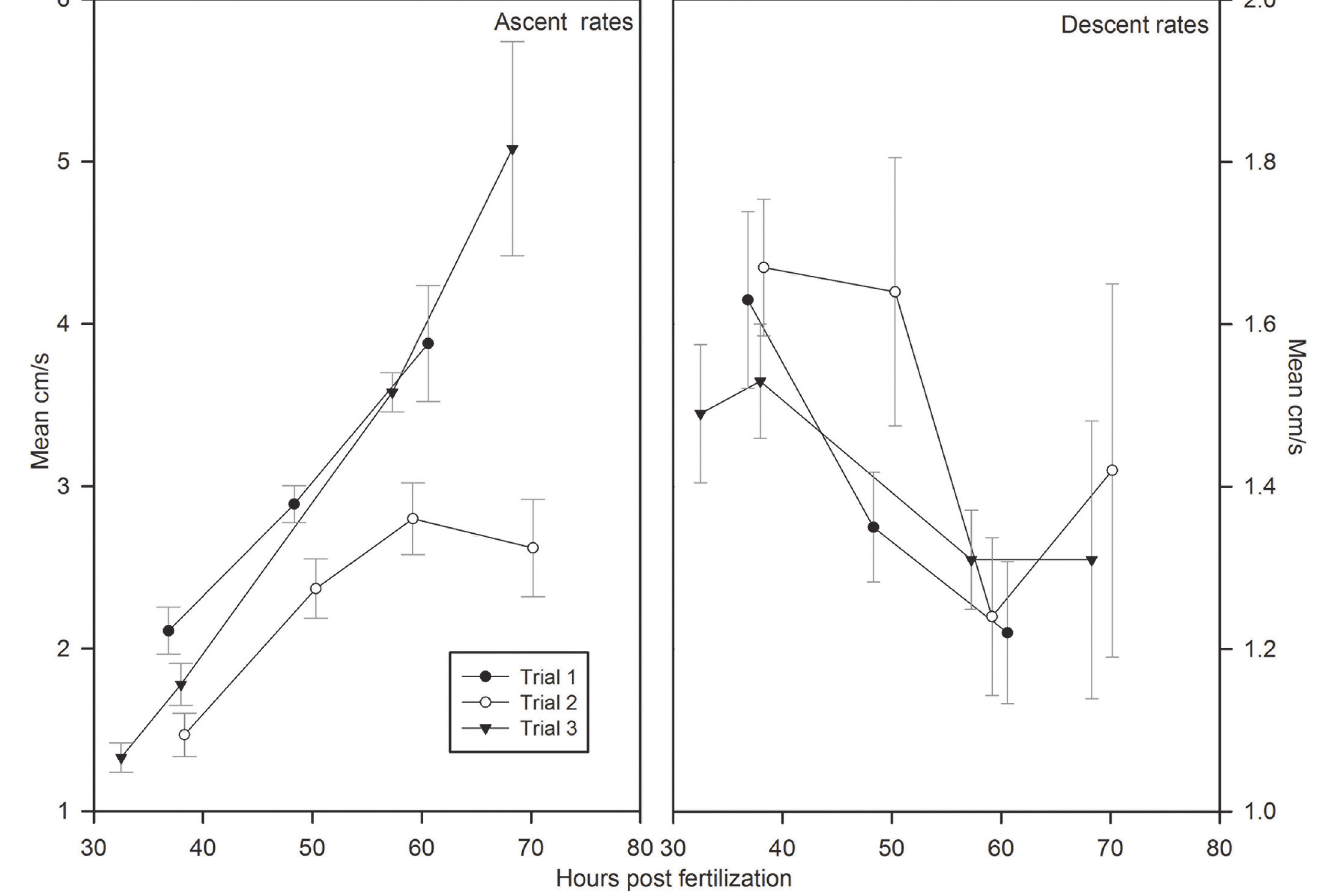
Fig 2. Mean ascent and descent rates (cm/s) for each of the three trials during the vertical swimming period. Error bars represent standard